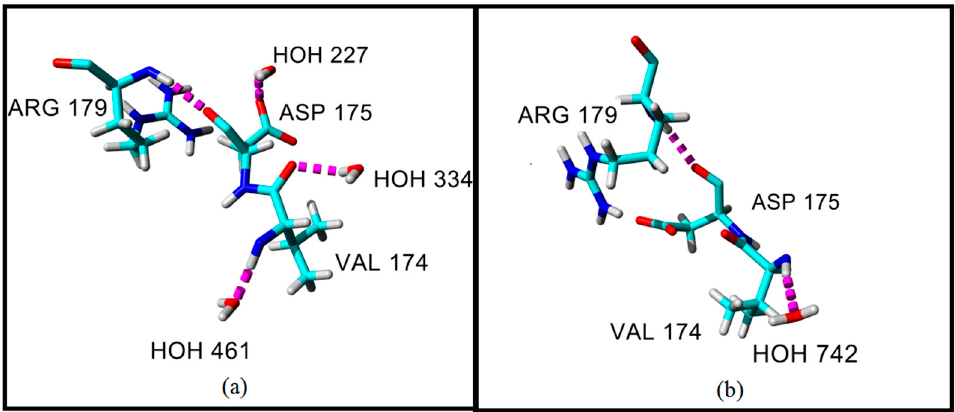
Figure 1. The conformation of residues Asp175, Arg179, and Val174 in T1 lipase crystal structures: ( a ) earth-grown T1 lipase crystal structure; ( b ) Space-grown T1 lipase crystal structure.